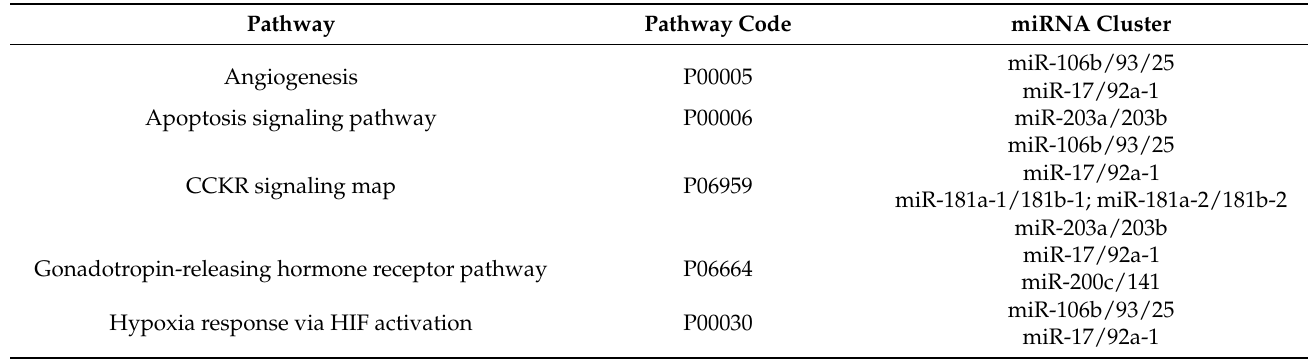
Table 7. Panther pathways significantly increased in the statistical overrepresentation test according to target gene miRNAs of miRNA